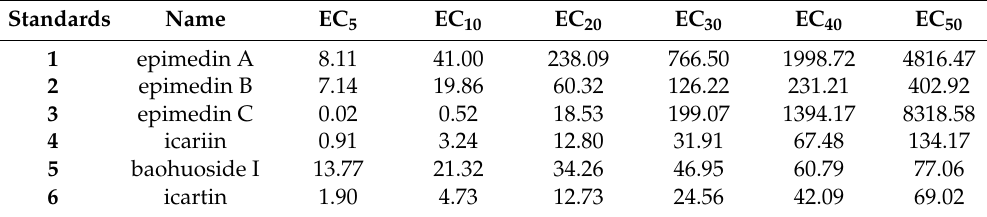
Table 1. EC 5–50 a values of six standards in the RAW264.7 growth inhibition test.